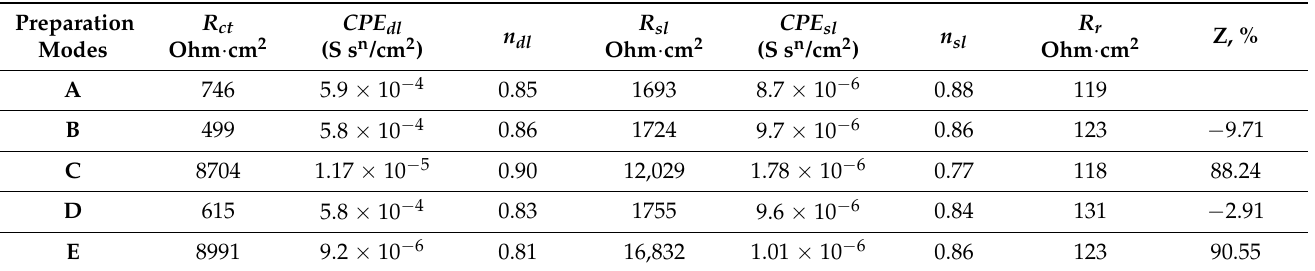
Figure 4. Nyquist plots of electrodes treated in modes A , B , C , D and E . Table 2. Impedance parameters calculated for electrodes treated in modes A , B , C , D and E